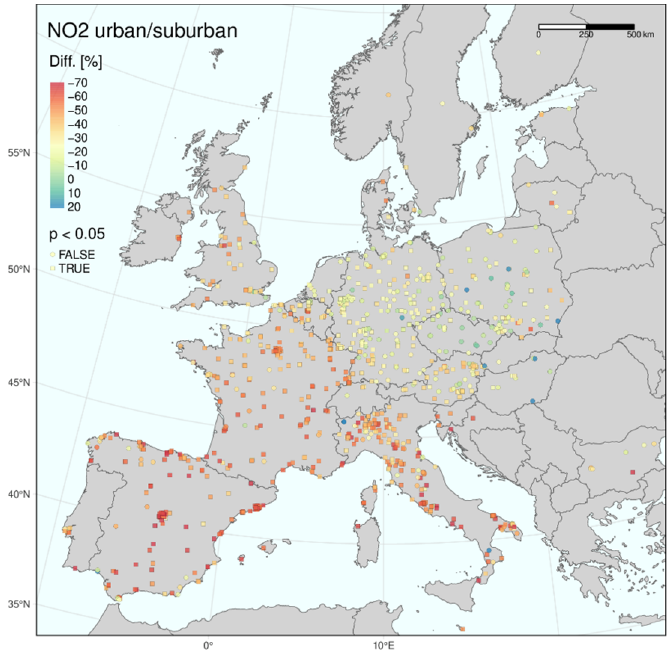
Figure 4. Same as Figure 3 for urban/suburban sites.